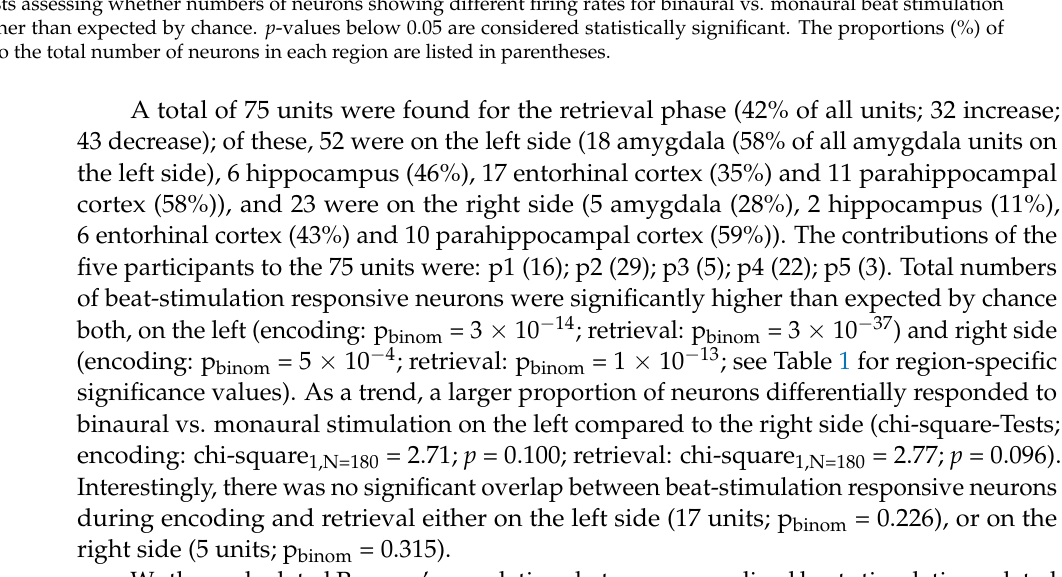
Results of binomial tests assessing whether numbers of neurons showing different firing rates for binaural vs. monaural beat stimulation were significantly higher than expected by chance. p -values below 0.05 are considered statistically significant. The proportions (%) of neurons with respect to the total number of neurons in each region are listed in